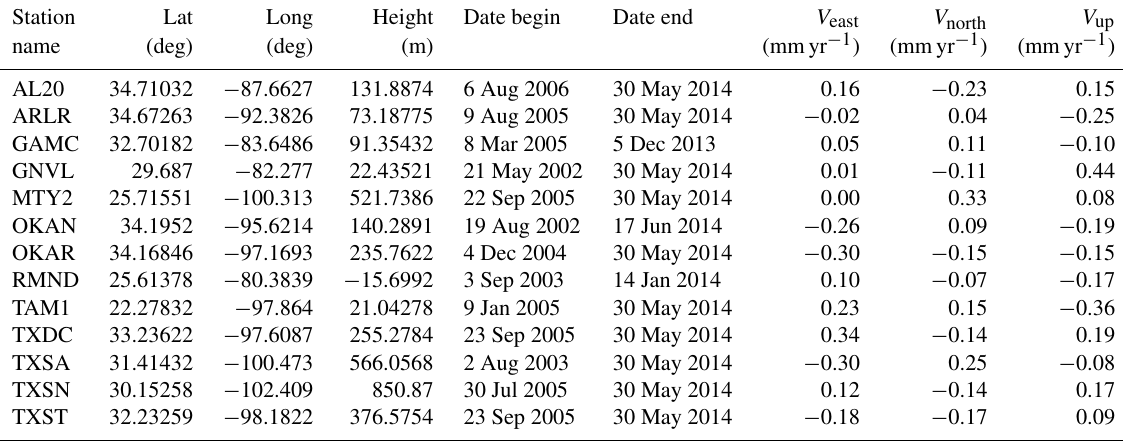
Table A2. Locations and velocities of 13 reference stations used to establish